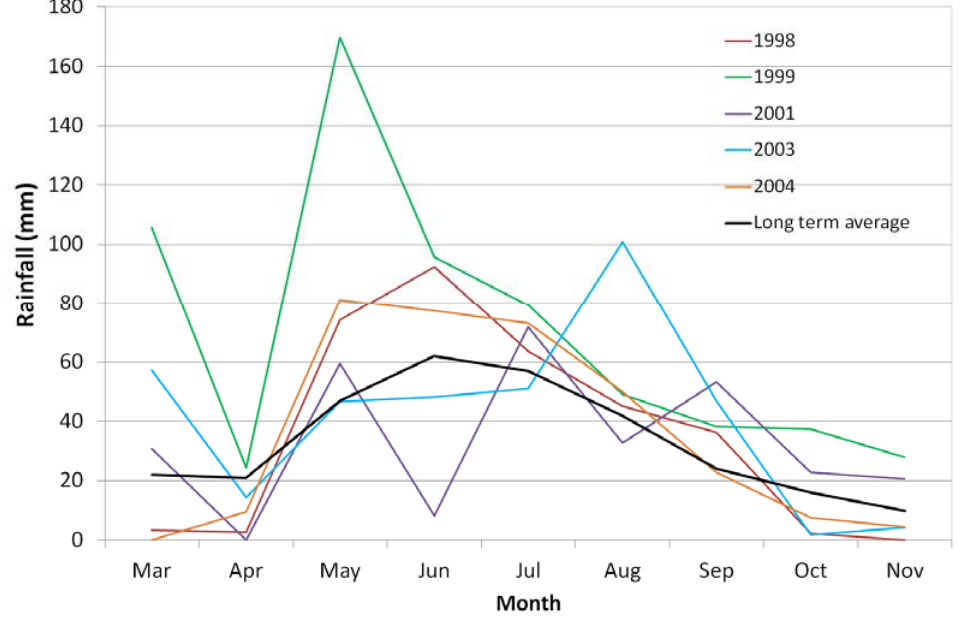
Figure 2. Monthly and long term average monthly rainfall for the five years of